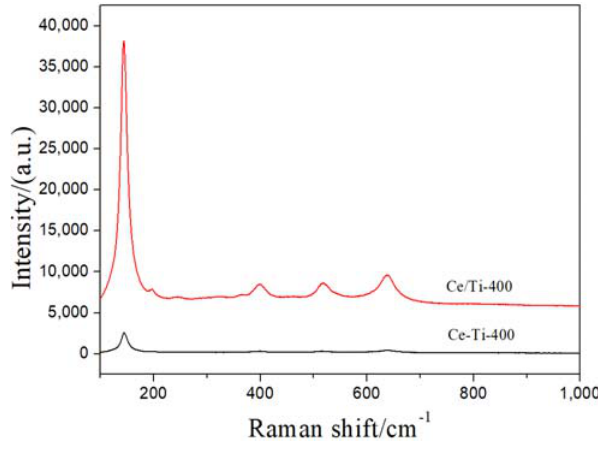
Figure 3. Raman spectra of Ce-Ti-400 and Ce/Ti-400.